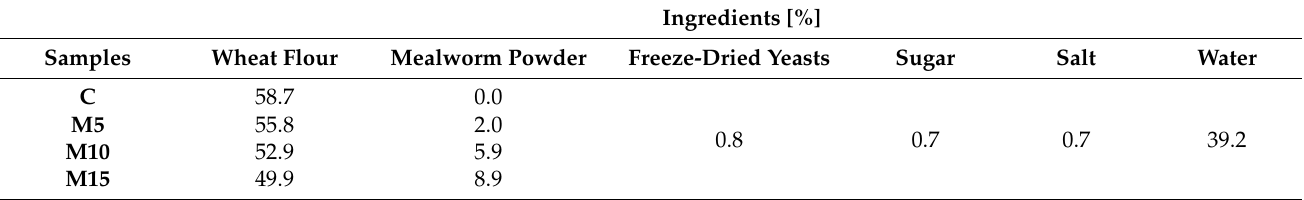
Table 2. Formulations of doughs obtained with the use of wheat flour (C), wheat and 5% (M5), 10% (M10), 15% (M15) mealworm powder.